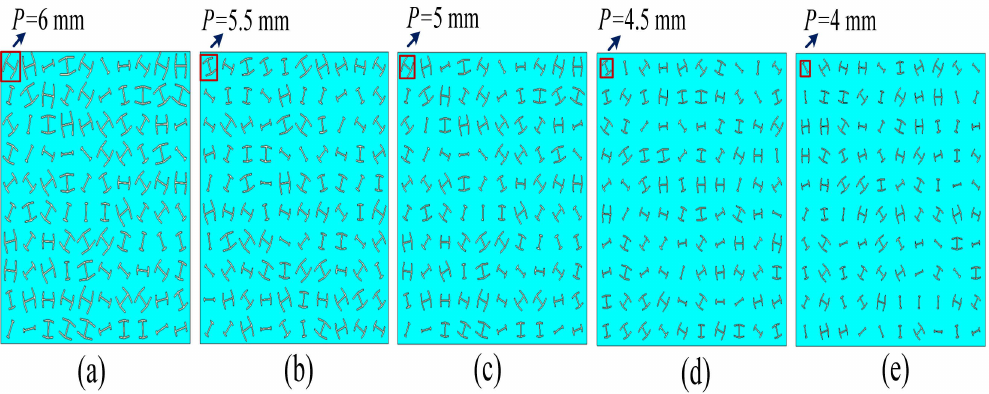
Figure 13. As length of period p varies from 4 mm to 6 mm with the step of 0.5 mm, five metasurfaces are presented. They are ( a ) metasurface 1; ( b ) metasurface 2; ( c ) metasurface 3; ( d ) metasurface 4; and ( e ) metasurface 5,